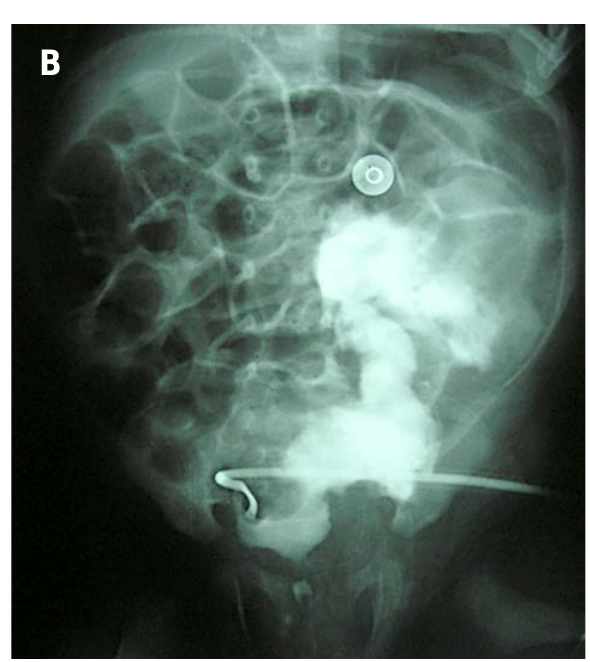
Figure 1 – Voiding cystourethrography of case #1. A) High- grade vesicoureteral reflux on the left side. B) Intraperitoneal bladder